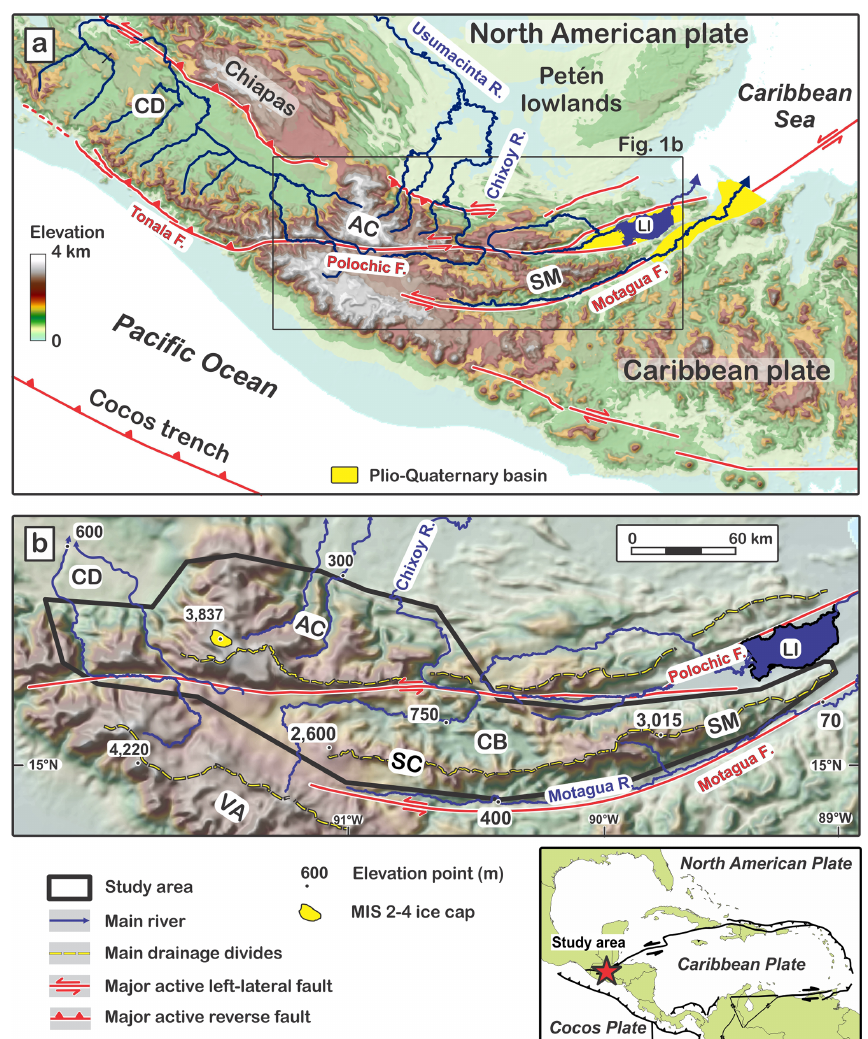
Figure 1. Shaded topography of the study area, showing the tectonic setting of central Guatemala (a) and of the studied range (b) . Topo- graphic features are defined as follows: CB stands for Chixóy River basin, CD stands for Central Depression of Chiapas, AC stands for Altos de Cuchumatanes (AC range), LI stands for Lake Izabal, SC stands for Sierra de Chuacús (SC range), SM stands for Sierra de las Minas (SM range), and VA stands for Central American Volcanic Arc. MIS represents the δ 18 O marine isotopic